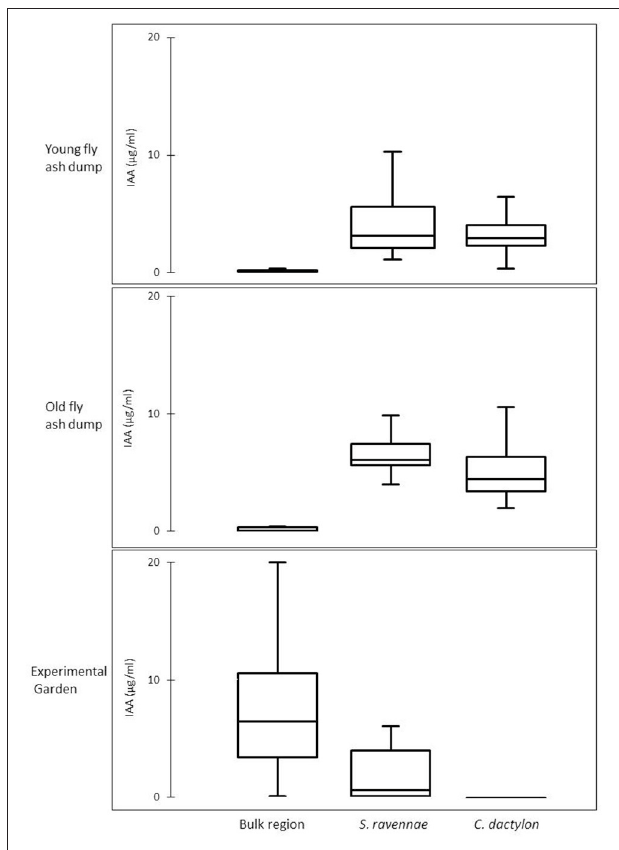
FIGURE 3 | Variability in IAA production of bacterial communities from non-rhizosphere (bulk) and rhizosphere ash/soil samples of S. ravennae and C. dactylon from fly ash dumps of different age and experimental